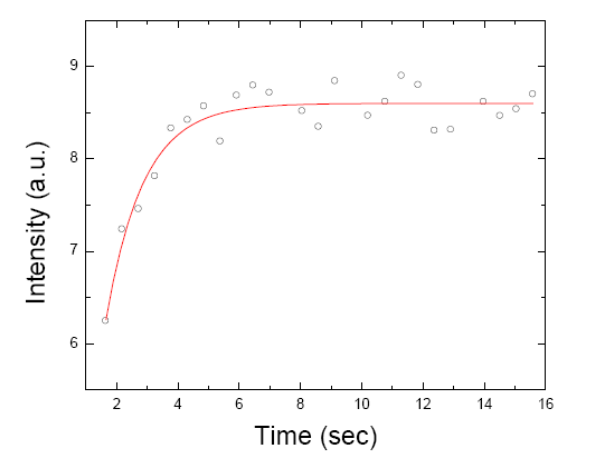
Figure 2. A fluorescence recovery versus time curve of fluorescein isothyocyanate (FITC) inside a GUV, as obtained by FRAP (unpublished results of the